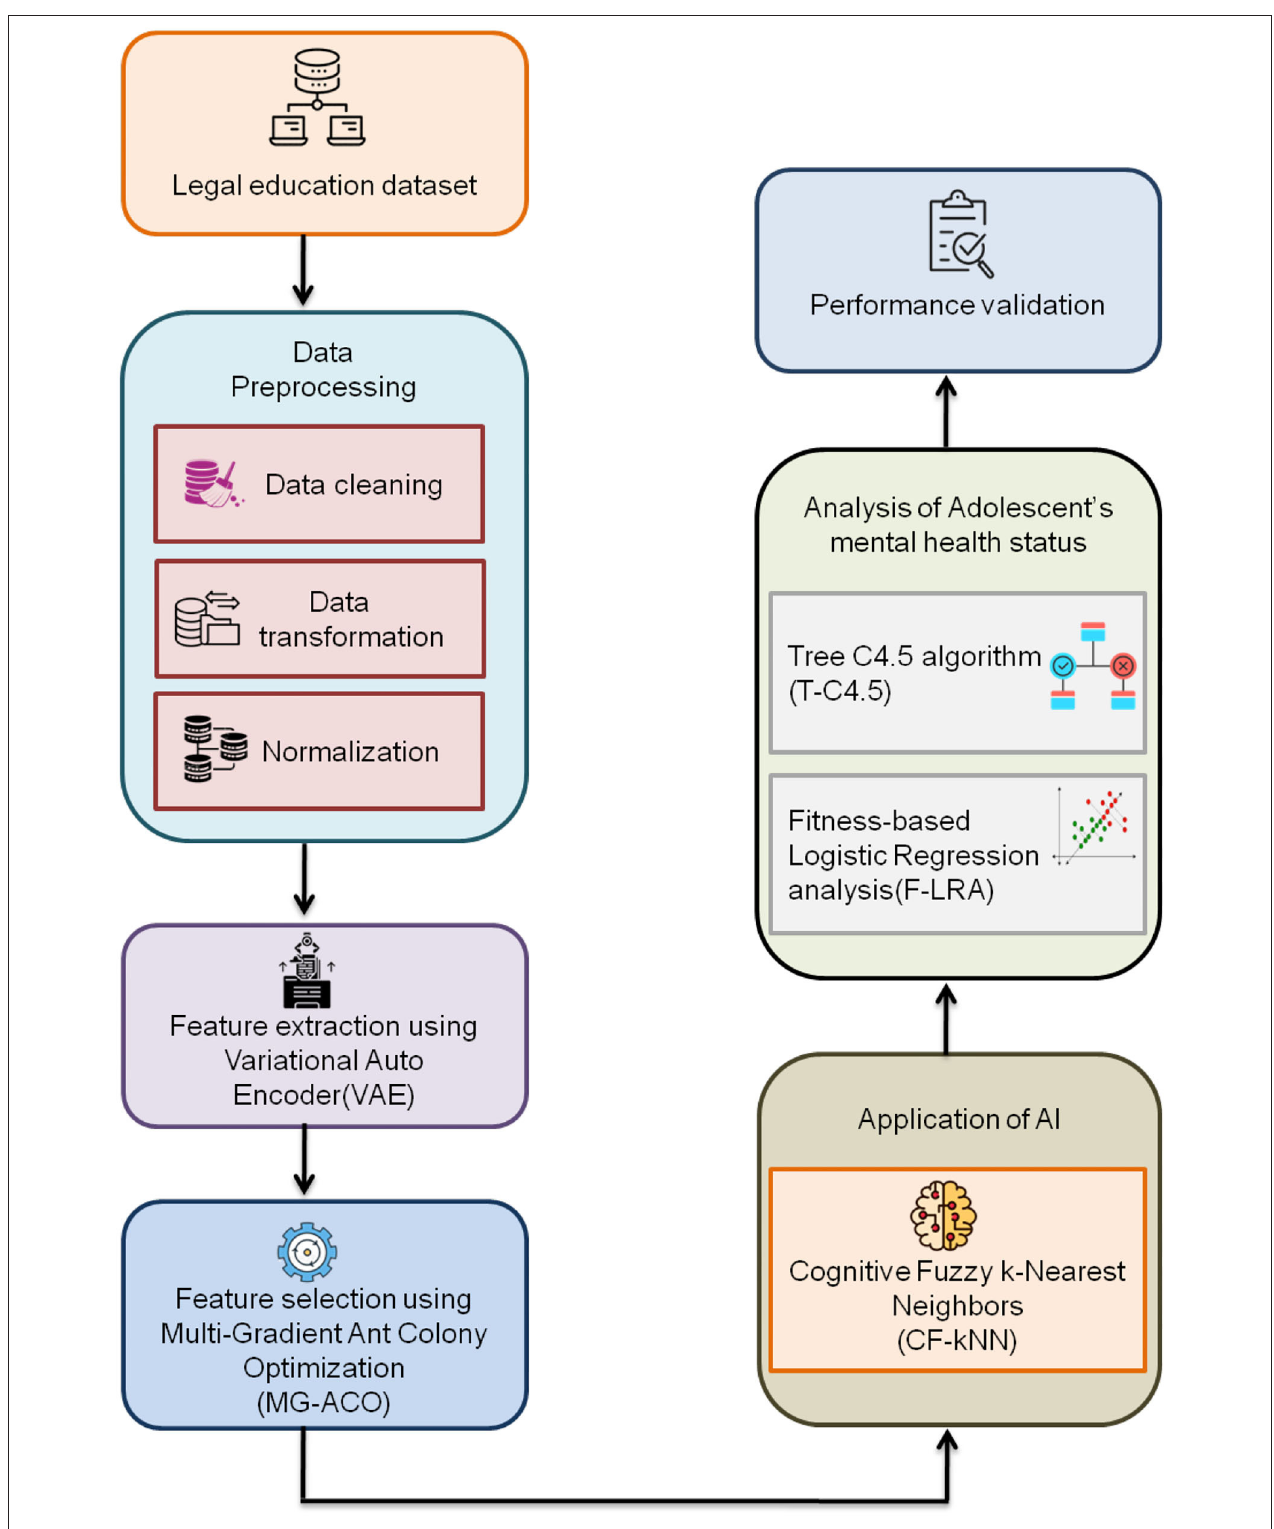
FIGURE 2 | Complete framework of proposed